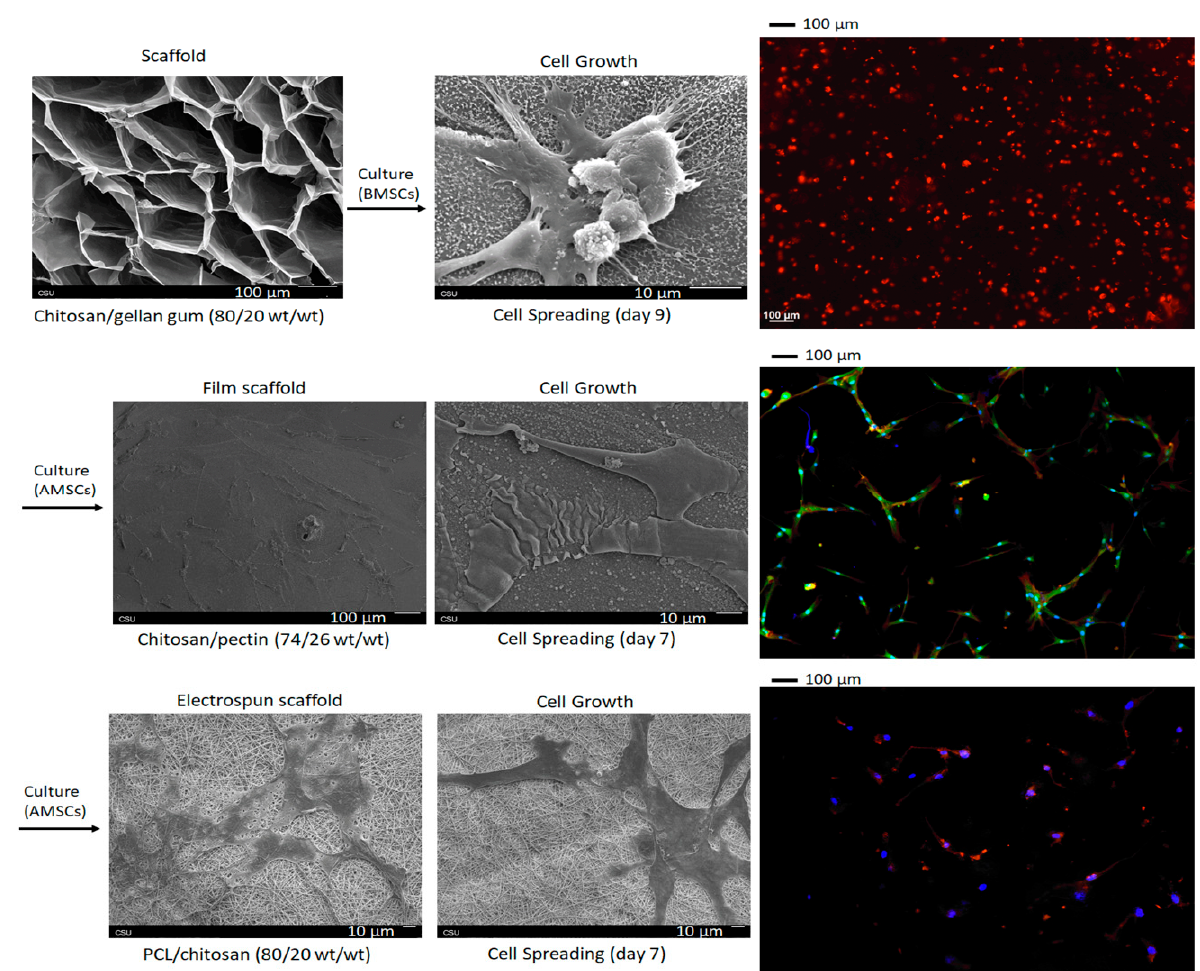
Figure 9. SEM and fluorescence images of mammalian cells seeded on polysaccharide-based scaffolds. (PCL = poly( ε -caprolactone), BMSCs = bone-marrow-derived mesenchymal stem cells and AMSCs = adipose-derived mesenchymal stem cells.) Reprinted with permission from References [138,145]; published by Elsevier, 2018 and 2020, respectively. Reprinted with permission from Reference [206]; published by SciELO, 2019.